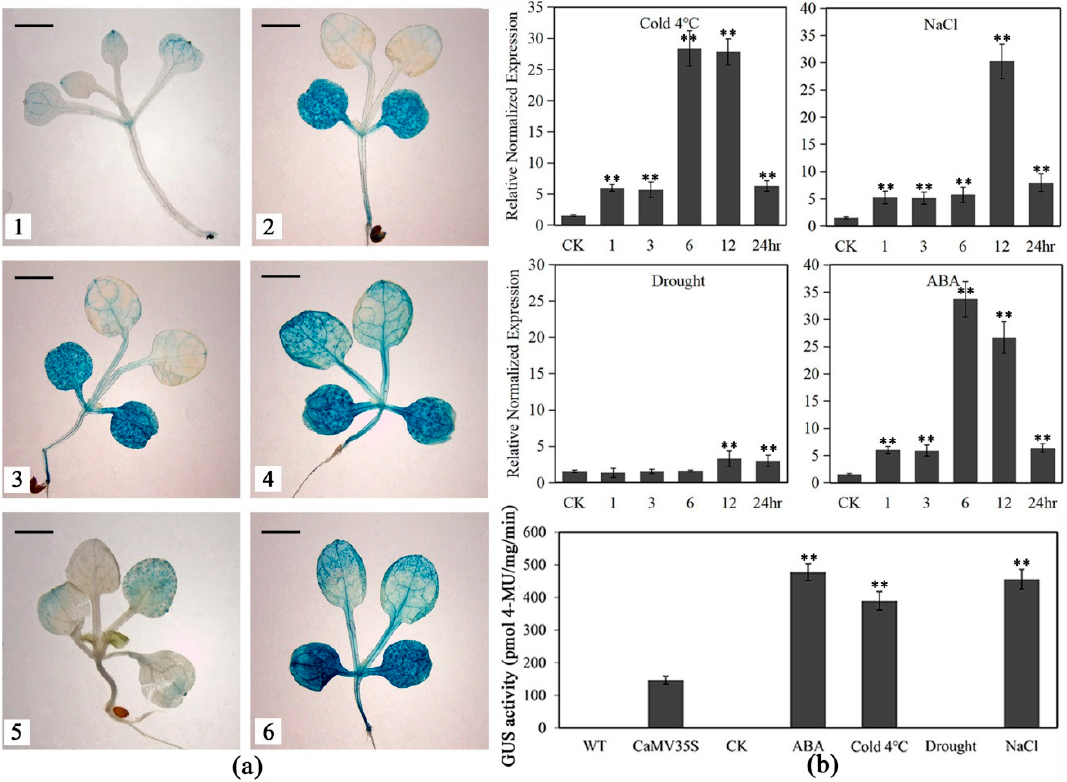
Figure 4. GUS activity mediated by LlNAC2 promoter in transgenic Arabidopsis plants. ( a ) Beta-glucuronidase (GUS) expression in untreated (1), cold (3), NaCl (4), drought (5), and ABA-treated (6) proLlNAC2-trans and CaMV35S-trans (2) Arabidopsis plants (Scale bar, 2 mm). ( b ) The GUS transcript levels and enzyme activity in the leaves of the transgenic Arabidopsis under cold (4 ◦ C), salt, drought, and ABA treatments. The transgenic plants treated for 12 h under above treatments were used for fluorometric GUS assay. GUS activity from the CaMV35S-trans, untreated proLlNAC2-trans (CK), and wild type (WT) served as controls. Twelve transgenic lines were acquired. Three biological replications were performed. The bars show the SD. Asterisks indicate a significant difference (** p < 0.01) compared with the corresponding controls.